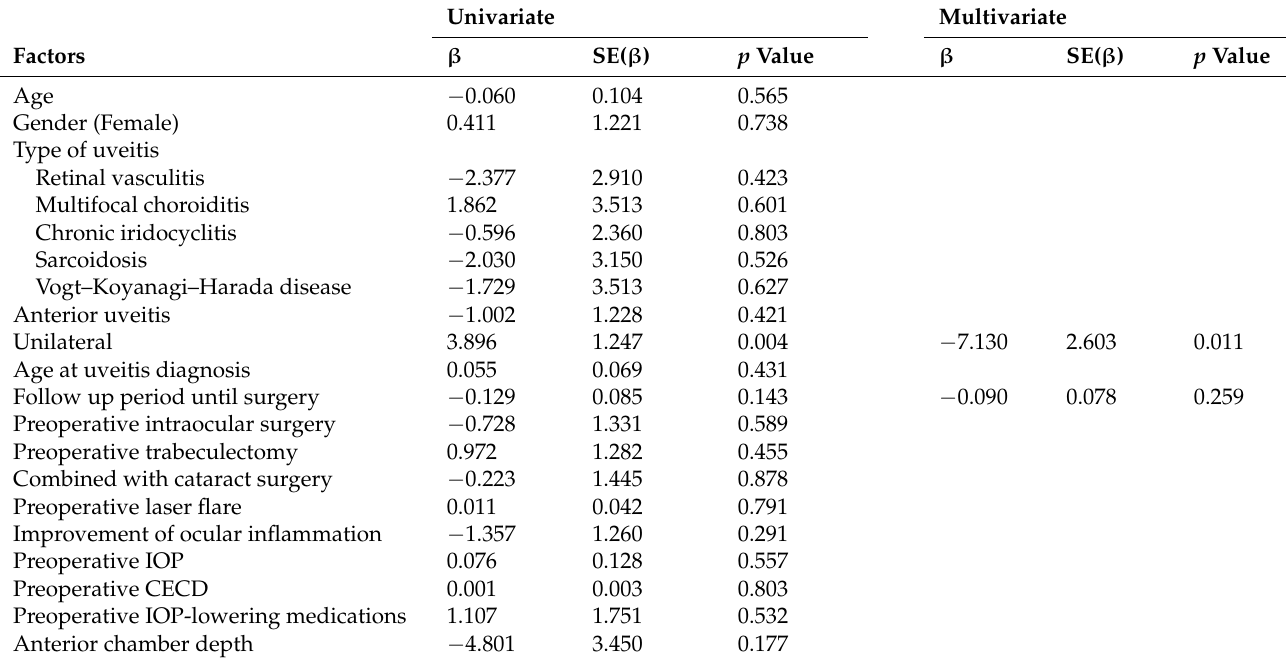
Table 3. Stepwise multiple regression analysis for factors associated with postoperative CECD changes.